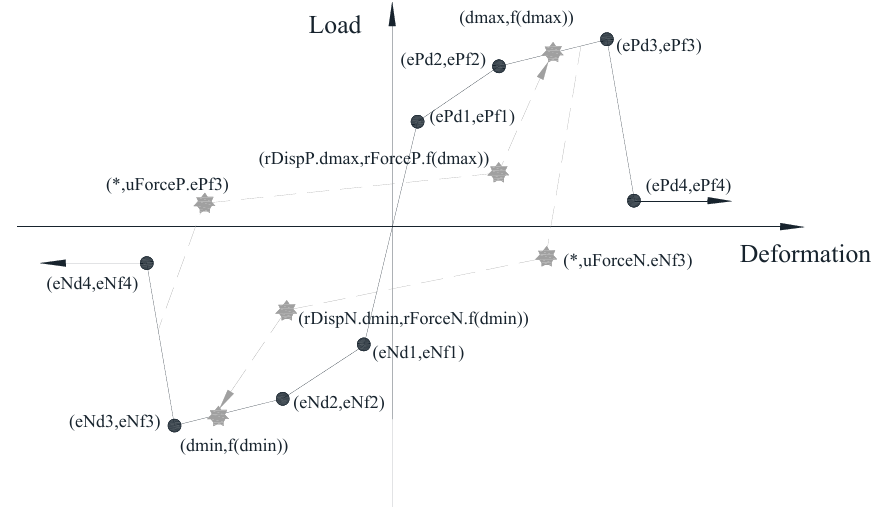
Figure 7. Hysteretic principle of the Pinching4 model.